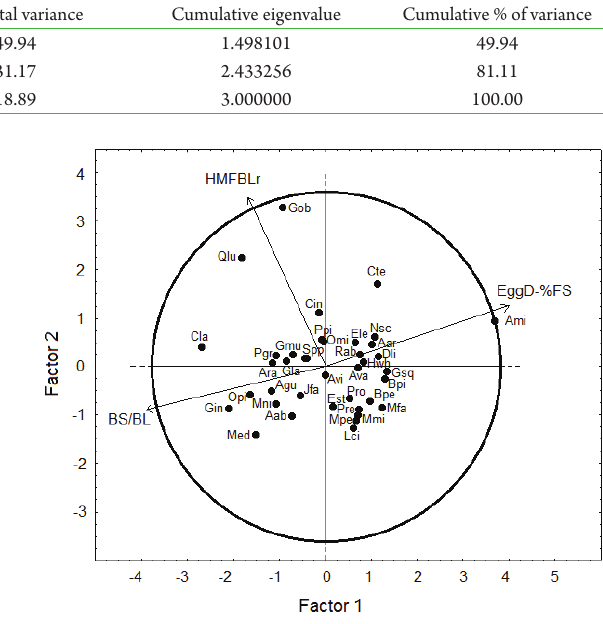
Figure 9. Position of Quadrivisio lutzi relative to other 38 amphipod species, over the 2D-plane formed by the main two PCA factors obtained from the three reproductive